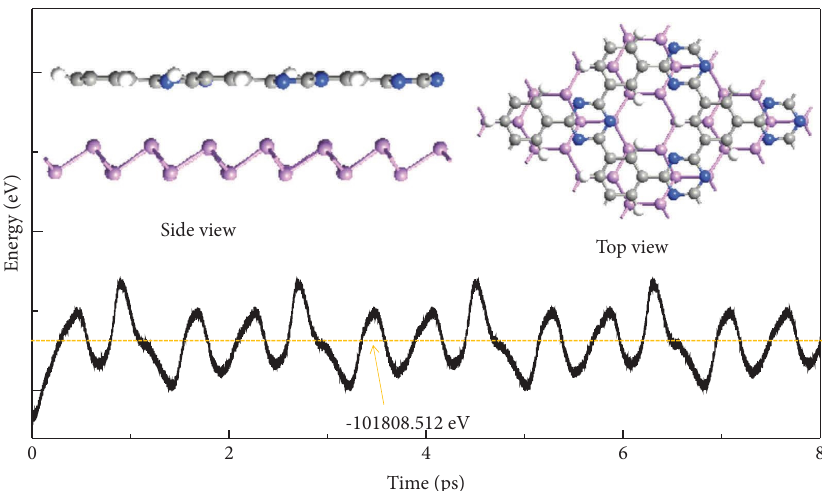
Figure 3: Te energy profle of CTF/As vdWhs as a function of AIMD simulation time. Te insets show the top and side perspectives of atomic structure of the heterostructure at